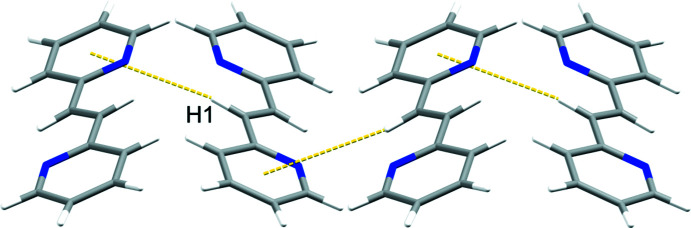
Corrugated, one-dimensional chains of 2,2′-bpe.